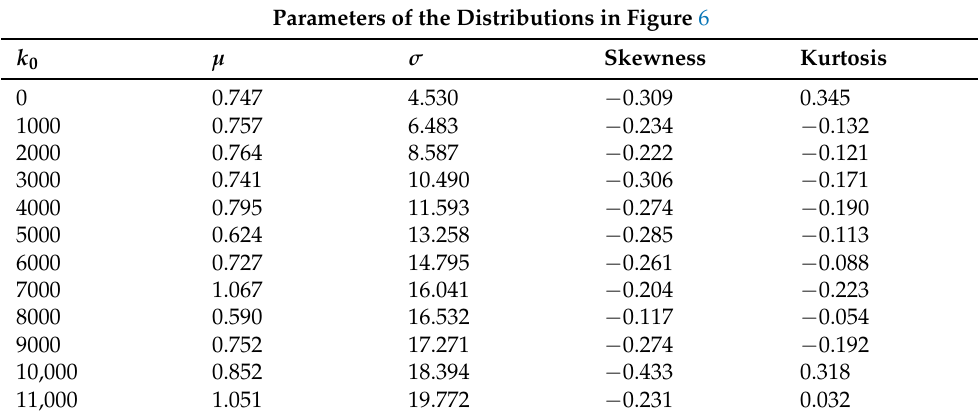
Table 1. Parameters of the distribution of Figure 6 for the wavenumber k -intervals starting at k 0 : the mean µ , standard deviation σ , skewness, and kurtosis.